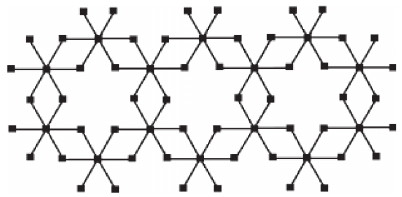
Figure 22: The chain for m � 3 (bismuth triiodide). Table 5: Degree-based edge partition of m − Bil vertices of each